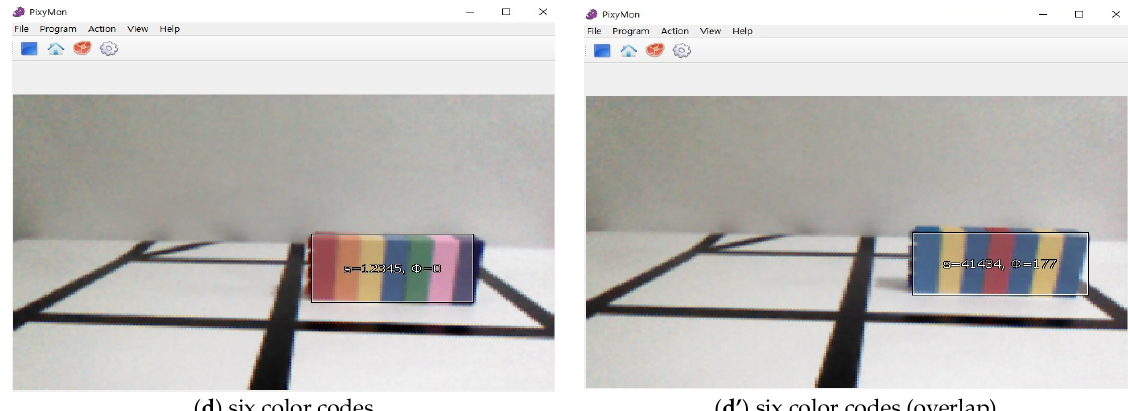
Figure 10. AGVA-Robot driving command using color codes.